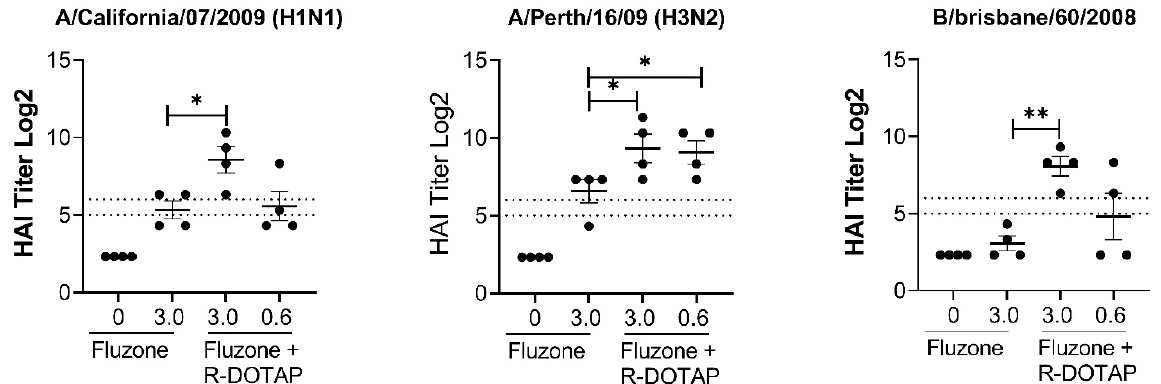
Figure 6. R-DOTAP significantly enhances the immunogenicity of Fluzone. Groups of C57BL/6J ( n = 4) mice were subcutaneously vaccinated on day 0 and day 21 with indicated dose of Fluzone vaccine (2011–12 formula) mixed with R-DOTAP, or PBS buffer. Serum from vaccinated mice were obtained 14 days after boost and tested for neutralizing antibodies using a hemagglutination inhibition assay (HAI) against viruses A/Perth/16/2009 (H3N2), A/California/07/2009 (H1N1) and B Brisbane. Data represent mean ± SEM of HAI titers. Dotted lines represent HAI titers range of 1:32–1:64. Data represent mean ± SEM of HAI titers from each mouse. Comparisons between sucrose alone or R-DOTAP groups was performed using Student’s t -test (unpaired-two tailed). * p ≤ 0.1, ** p ≤ 0.05.